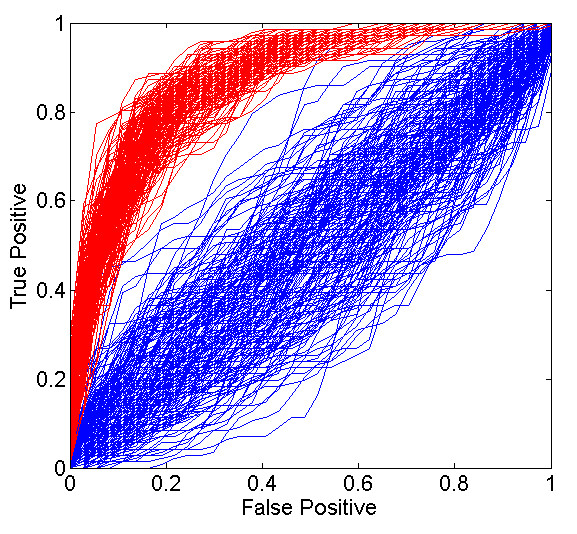
Simulation ROC curves. Receiver operating curves generated from 200 draws from the MCMC chain (red) compared to ROC’s generated from predictors of randomly generated outcomes (blue). The random predictors were generated from a mean zero multivariate normal distribution using a covariance matrix generated from the factor matrix Λ for the corresponding MCMC draw. The outcome variable (response/non-response) was then permuted before the ‘random predictor’ model was fit.